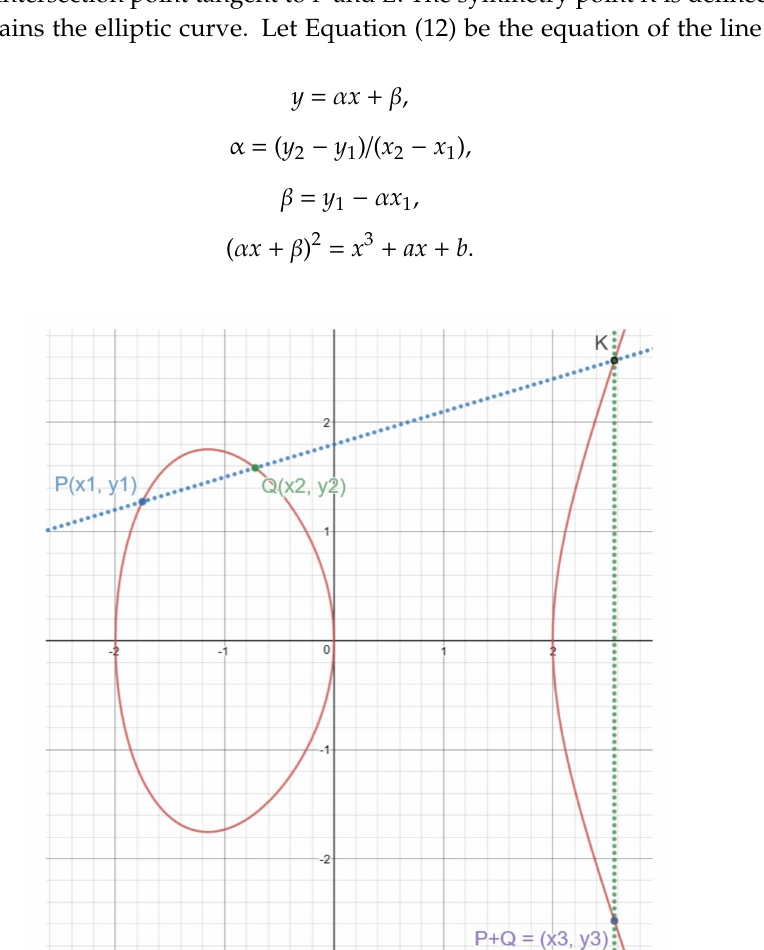
Figure 2. Addition of a group over elliptic